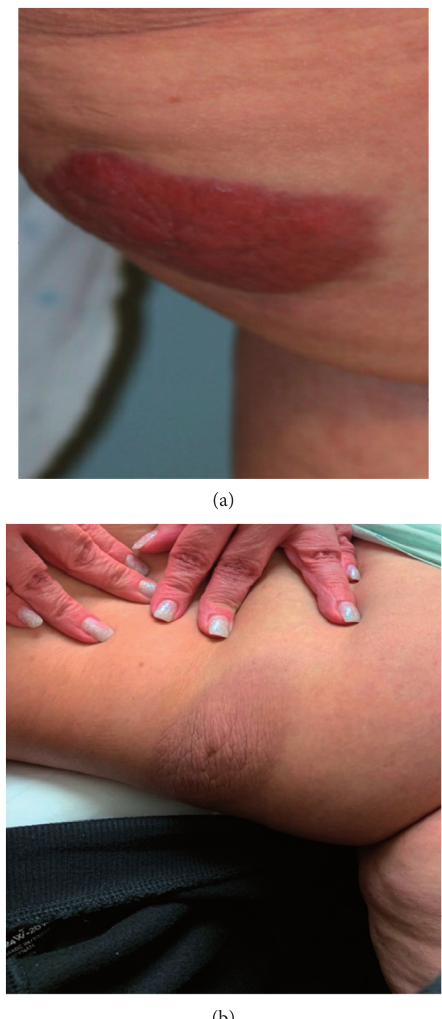
Figure 1: Patient B: clinical images of MF tumor before (a) and 1 month after (b) the removal of RCC and local radiation